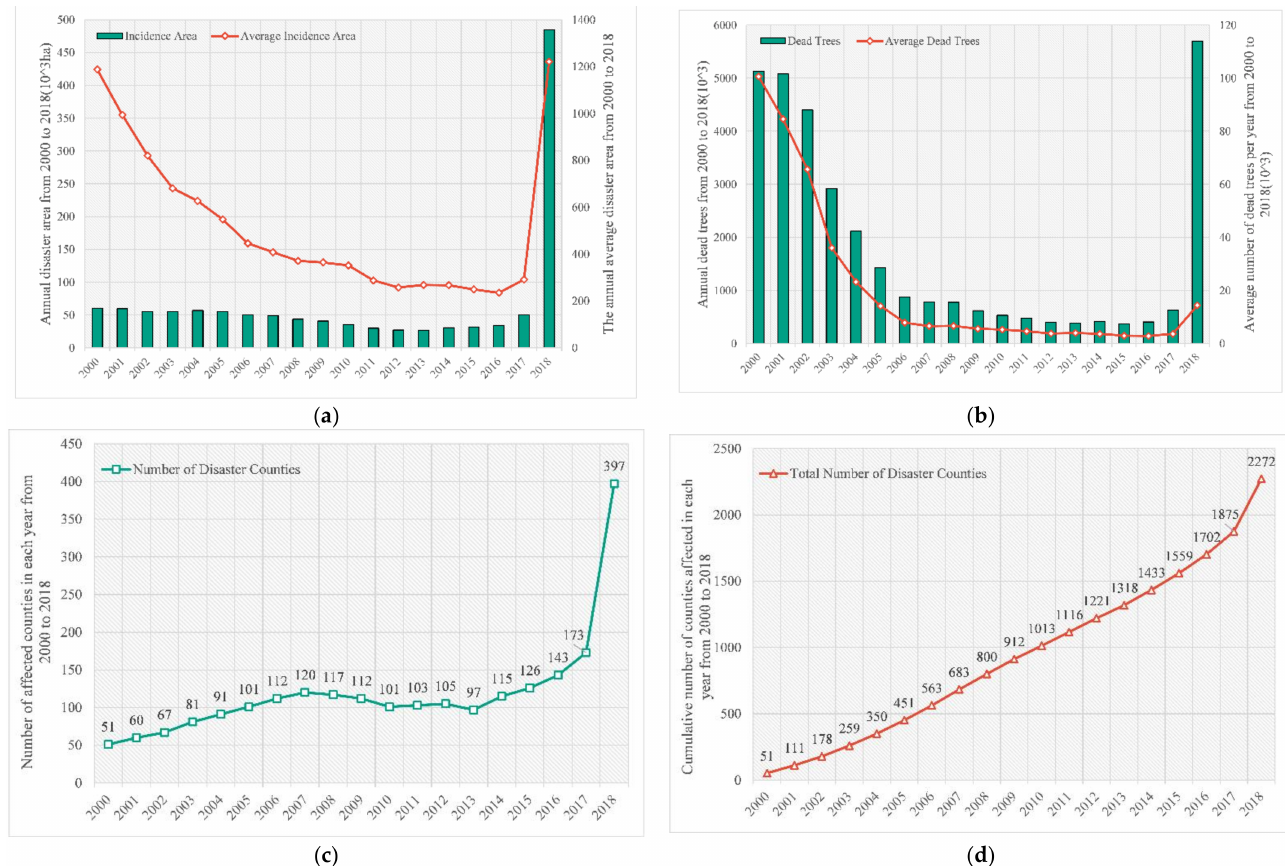
Figure 1. Disaster situation of pinewood nematodes in the Yangtze River Basin from 2000 to 2018: ( a ) disaster area and average disaster area of the affected area; ( b ) diseased and dead trees in the affected area and the mean number of dead trees; ( c ) the number of affected counties in the Yangtze Basin; ( d ) the cumulative number of affected counties in the Yangtze